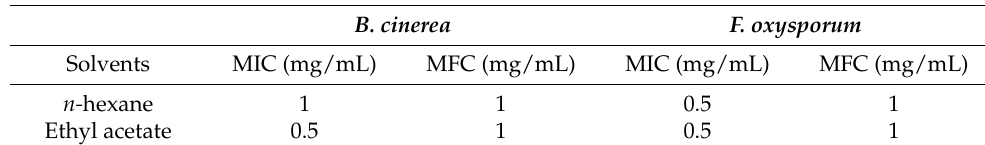
Table 3. Minimum inhibitory concentration (MIC) and minimum fungicidal concentration (MFC) shown by the n -hexane, ethyl acetate and ethanolic extracts from Asparagopsis armata against the spore germination of Fusarium oxysporum and Botrytis cinerea .